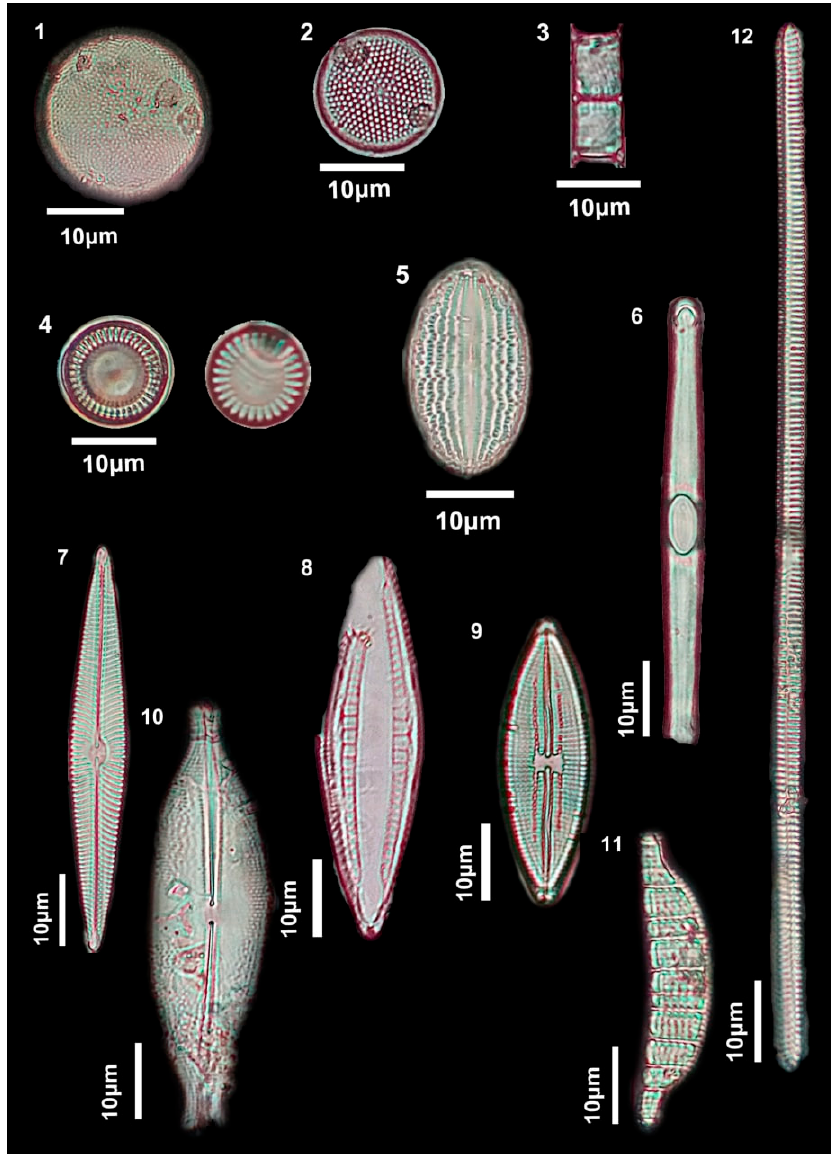
Figure 5. Diatoms of the studied Rybachya core. (1) Actinocyclus octonarius ; (2) Thalassiosira eccen- trica (Ehrenberg) Cleve, 1904; (3) Aulacoseira italica (Ehrenberg) Simonsen, 1979; (4) Stephanocyclus meneghinianus ; (5) Cocconeis lineata ; (6) Grammatophora macilenta ; (7) Navicula avenacea ; (8) Mastogloia pseudexigua; (9) Lyrella lyra; (10) Anomoeoneis sphaerophora (Pfitzer, 1871); (11) Epithemia adnata (Kützing) Br é bisson, 1838; (12) Ulnaria ulna (Nitzsch) Comp è re, 2001. Assemblage II (3.5–3.0 m) occurred within sapropels with plant remains. It was estab- lished by a high abundance of benthic diatoms (up to 100%) and a rather high concentration of diatom valves, which increases upwards from 1.8 to 13.2 mln valves/g (Figure 6). The periphyton species of the genus Epithemia dominate (70%). Subordinate species are brackish water Navicula libonensis (Schoeman, 1970) and Mastogloia pseudexigua (Cholnoky, 1956) (Figure 5). In the diatom assemblage, poor preservation of the valves and an increasing abundance of alkaliphilous and alkalibiontic diatoms was